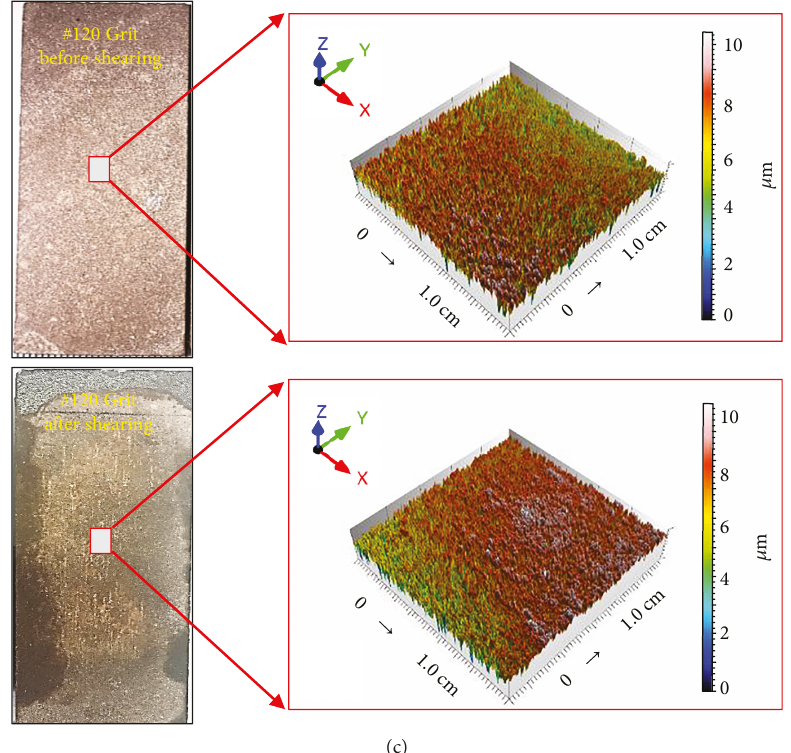
Figure 6: Unsheared and sheared fracture surfaces and the corresponding 3-D views: (a) #36 Grit; (b) #80 Grit; (c) #120